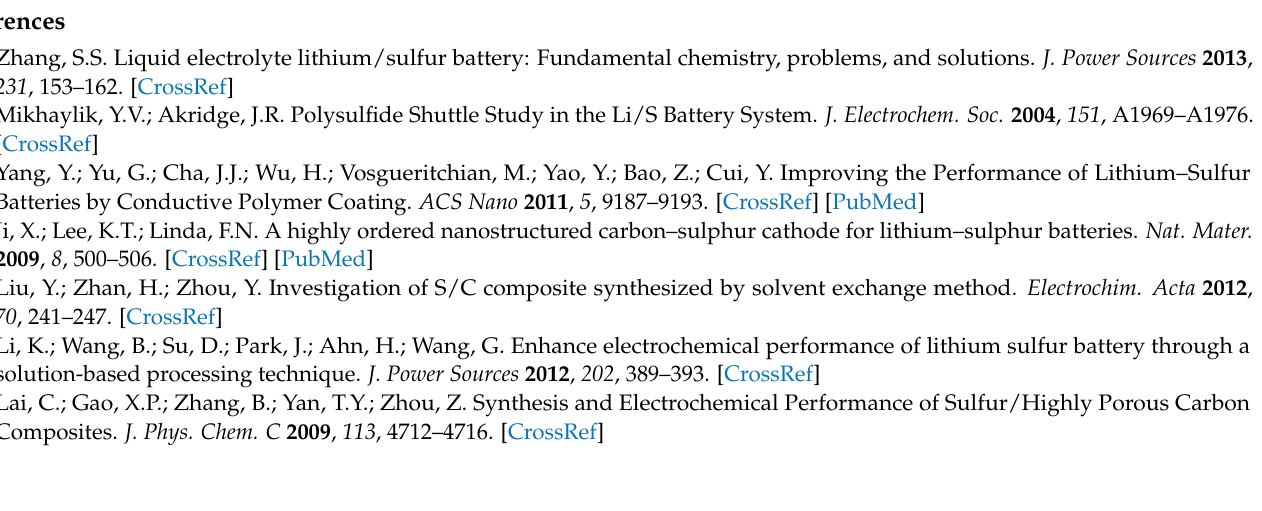
Table S1: Elemental content of the MPC and MPC-sulfur composites in